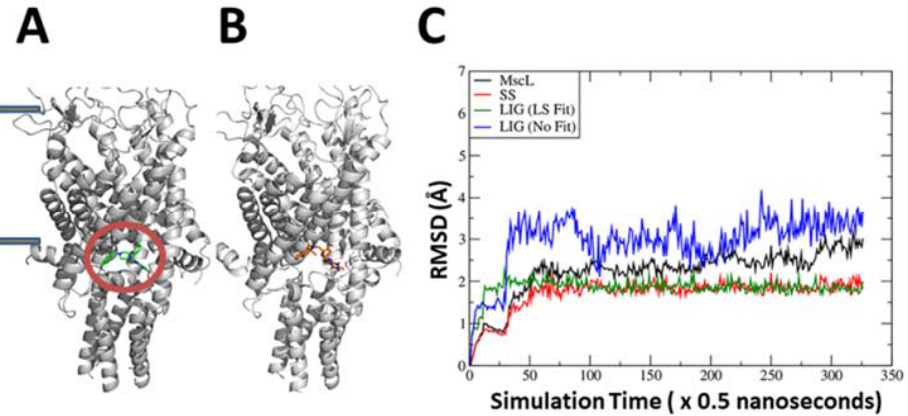
Figure 1. The binding site of compound 262 within the MscL structure as determined by docking and molecular dynamics (MD) simulations. ( A ) The docking pose of the compound, shown in green within the red circle at the cytoplasmic–membrane interface. The boundaries of the lipid bilayer are marked by the grey rectangles on the left. ( B ) Representative conformation of the ligand, in